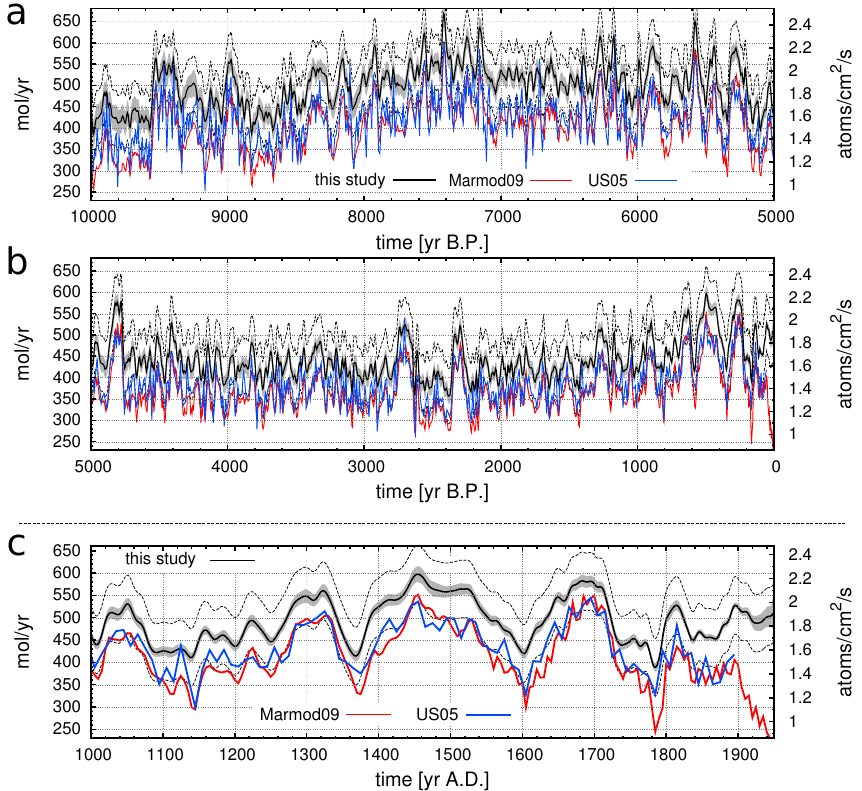
Fig. 10. (a, b) Total 14 C production rate from this study (black line with grey 1 σ shading) and the reconstructions from Usoskin and Kromer (2005) (blue) and the output of the Marmod09 box model (red). The grey shading indicates ± 1 σ uncertainty as computed from statistical uncertainties in the atmospheric 1 14 C records and in the processes governing the deglacial CO 2 increase, air–sea gas transfer rate and global primary production on land (see Appendix and Fig. A1). (c) Shows the last 1000yr of the production record in more detail. The two dashed lines indicate the potential offset of our best guess production rate due to the ∼ 15% (1 σ ) uncertainty in the data-based radiocarbon